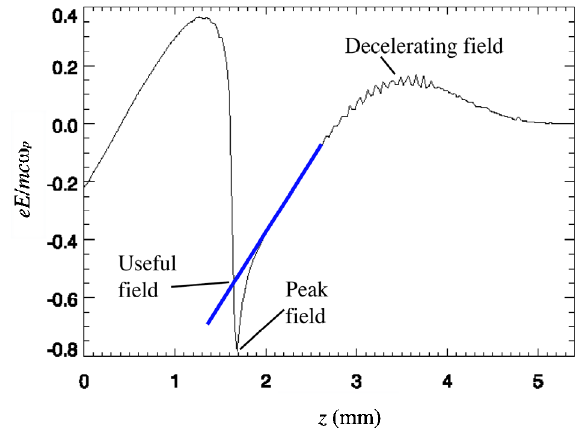
FIG. 1. (Color) The longitudinal field profile given by PIC simulation for PWFA excitation in the blowout regime. The decelerating field, peak accelerating field, and a defined ‘‘useful field,’’ which avoids the narrow spike region, are indicated in the